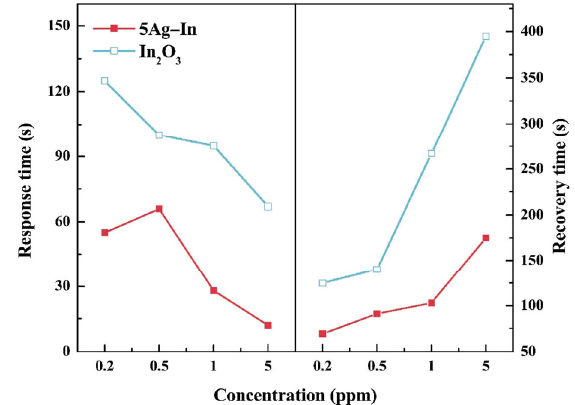
Fig. 10 Responses of the seven sensors to 0.2–5 ppm isopropanol at 300 . ℃